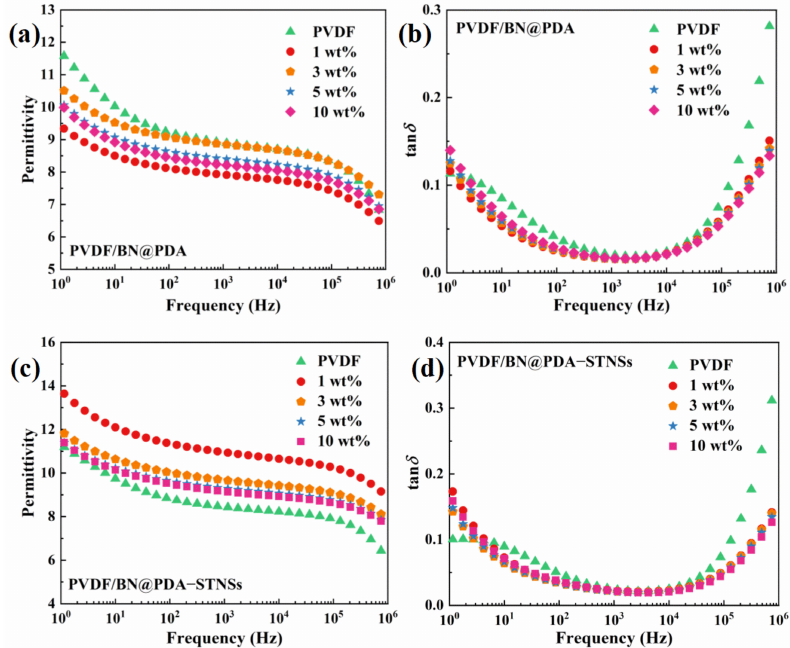
Figure 5. Dielectric permittivity of ( a ) PVDF/BN@PDA and ( c ) PVDF/BN@PDA − STNSs composites. Dielectric loss tangent of ( b ) PVDF/BN@PDA and ( d ) PVDF/BN@PDA − STNSs